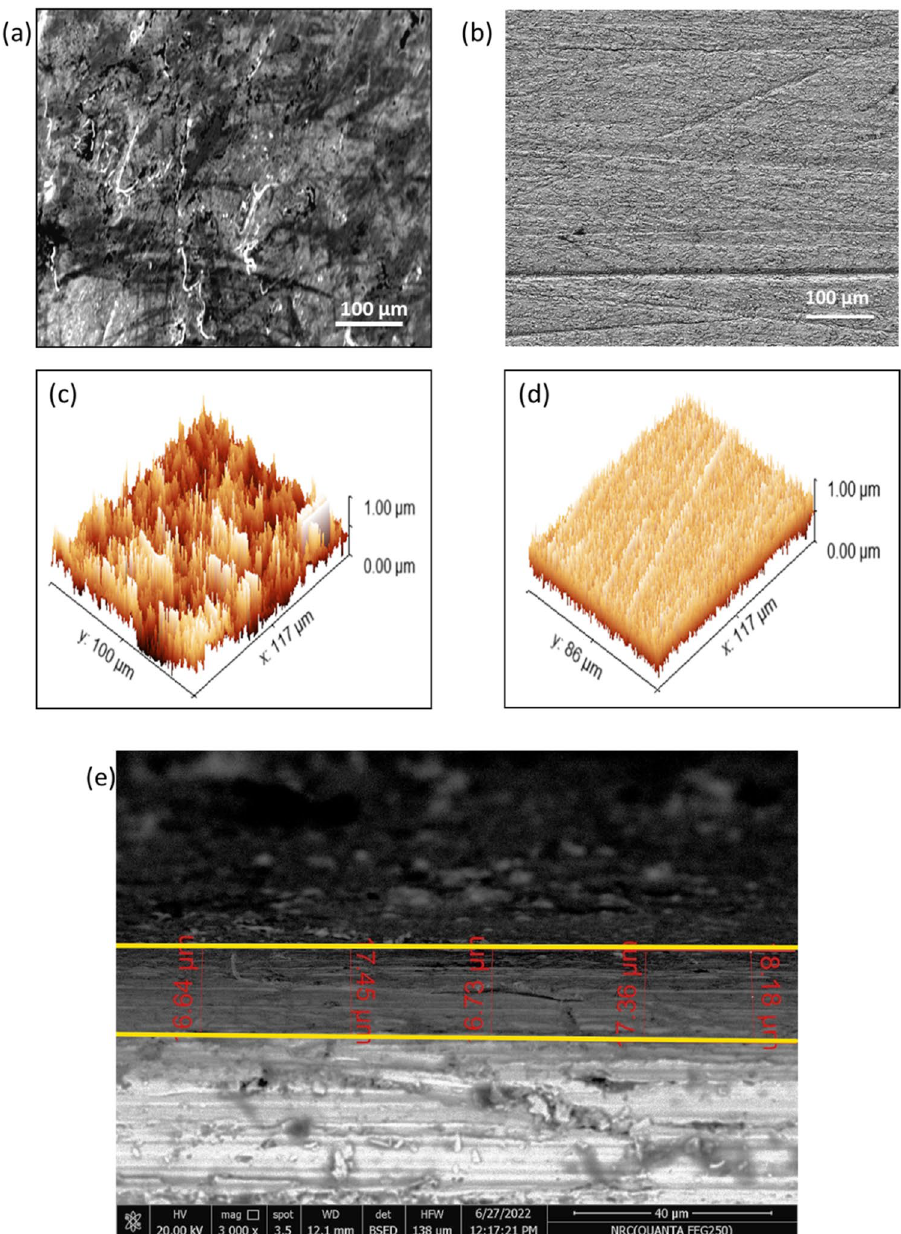
Figure 14. SEM micrographs for: ( a ) bare and ( b ) mild steel coated by Ch/GA nanocomposite. The 3D AFM images for ( c ) bare and ( d ) mild steel coated by Ch/GA nanocomposite. ( e ) The SEM cross-sectional image of mild steel coated by Ch/GA